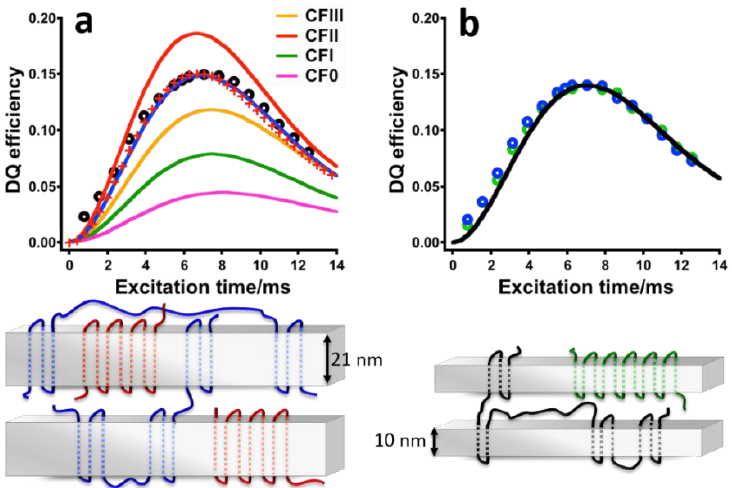
Figure 9. 13 C – 13 C DQ buildup curves for 35% 13 C – CH 3 enriched i PB1 crystal blends with a non-labeled one with a mixing ratio of 1/9, formed at ( a ) 95 °C (black open circles), ( b ) 50 °C (blue open circles), and ~ 0 °C (green open circles). ( a ) The calculated DQ buildup curves based on CF0 (pink), CFI (green), CFII (red), and CFIII (orange) under the assumption of < n > = 5 and < F > = 100%. The calculated DQ curves for CFII with < n > = 2 and < F CFII > = 100% (blue solid curve), and < n > = 5 and < F CFII > = 80% (red crosses). ( b ) The calculated DQ buildup curves for CFII with < n > = 1.7 with F CFII > = 100% (black solid) at T c = 50 °C and ~0 °C. Schematic illustrations of plausible chain-folding patterns in the lamellae: < n > = 5 (red chain) and < n > = 2 (blue) on the bottom of ( a ) and < n > = 10 (green) and < n > = 1.7 (black) on the bottom of ( b ). (Reprinted with permission from Macromolecules 2015 , 48 , 3282 – 3293. Copyright (2015) American Chemical Society).